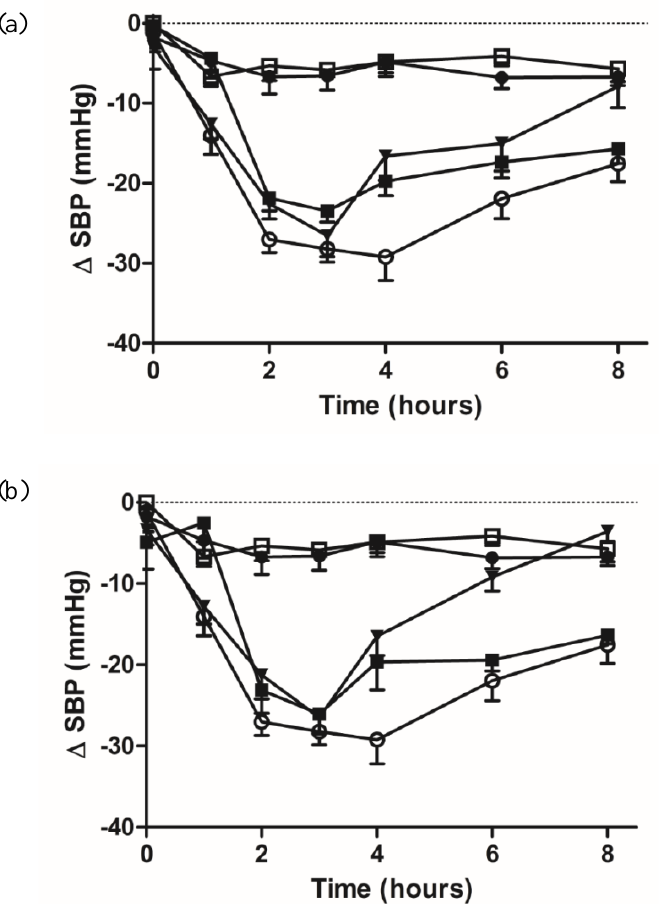
Figure 9. Change in SBP after oral administration to SHRs. ( a ) IPP and ( b ) LKP in free or entrapped Figure 9: Change in SBP after oral administration to SHRs. (a) IPP and (b) LKP in free or